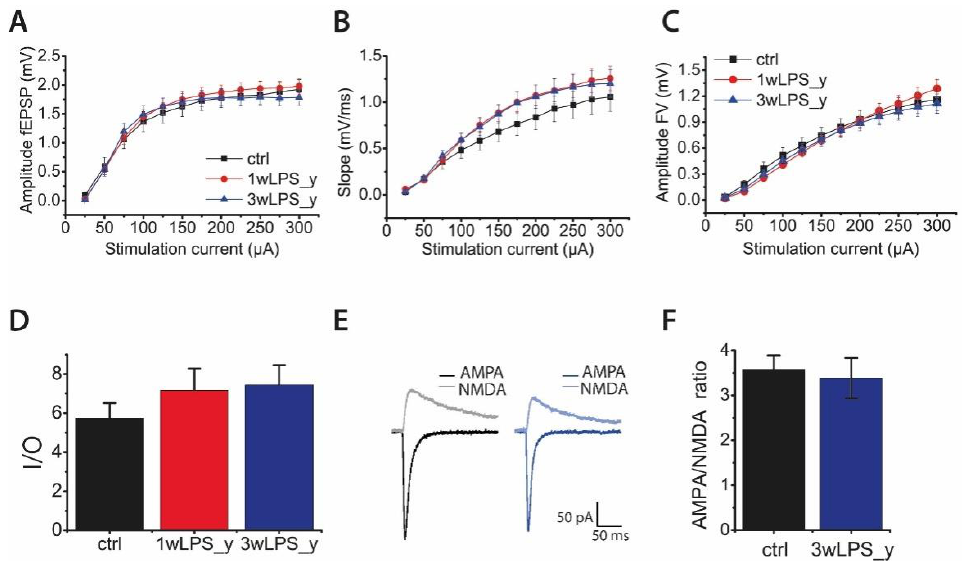
Figure 2. The main features of excitatory synaptic transmission in hippocampal pyramidal neurons are not altered after LPS treatment. The relationships between stimulation current and fEPSP amplitudes ( A ), slopes ( B ), and presynaptic fiber volley (FV) amplitude ( C ) recorded from the hippocampal CA1 area. ( D ) The diagram shows the maximum slope of the input/output (I/O) curve in different groups. ( E ) Representative examples of evoked EPSCs recorded at –80 mV and +40 mV from control rats and rats treated with LPS. The AMPA component was obtained by measuring the excitatory postsynaptic current (EPSC) peak amplitude at –80 mV in the presence of the GABA A R blockers bicuculline (10 μM) and picrotoxin (50 μM). The N-methyl-D-aspartate (NMDA) component was obtained by measuring the EPSC peak amplitude at +40 mV in the presence of gamma- aminobutyric acid type A receptor (GABAa) blockers and the AMPAR blocker, CNQX (20 μM). ( F ) The diagram illustrates the AMPA/NMDA ratio in the control and 3wLPS_y groups. Error bars indicate standard errors SE.